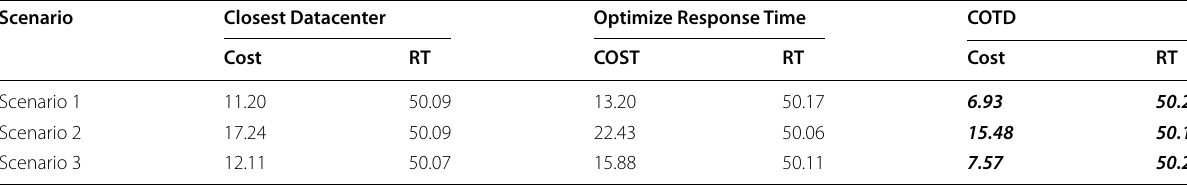
Table 4 Results of the proposed algorithm